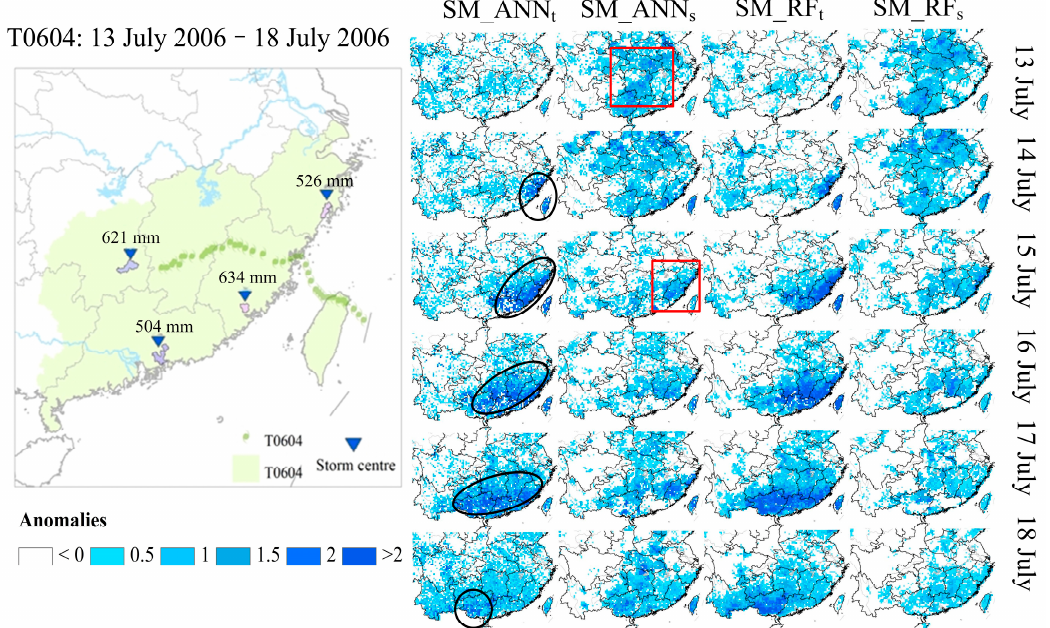
Figure 8. Spatial variations in anomalies of reconstructed soil moisture series in the temporal and spatial domains with the ANN and RF models (denoted as SM_ANNt, SM_ANNs, SM_RFt, and SM_RFs, respectively) during the fourth typhoon Bilis (from 13 July 2006 to 18 July 2006). The black solid circles show the regions where SM_ANNt accurately capture the increments in soil moisture, and the red solid rectangles show the poor performances of SM_ANNs.